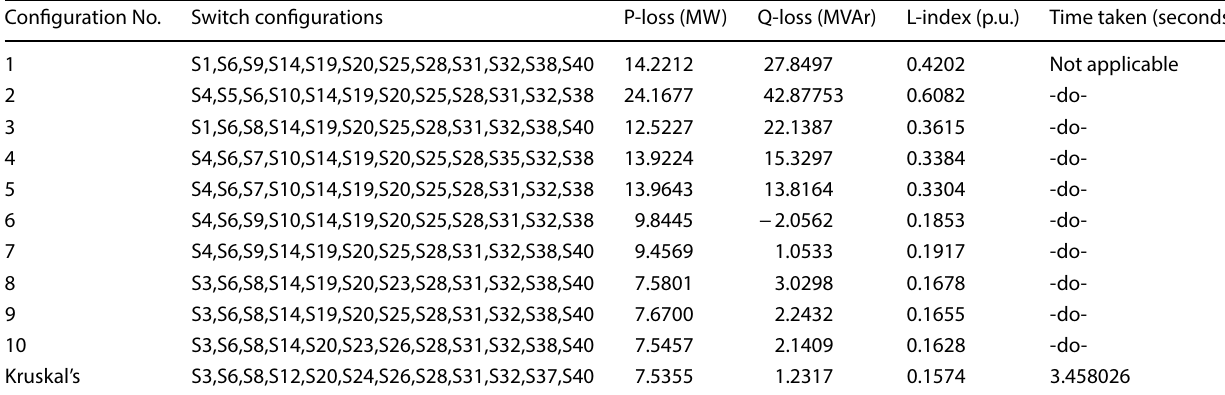
Table 7 Calculated values of L-index, P-loss, and Q-loss at 60% of base load Configuration